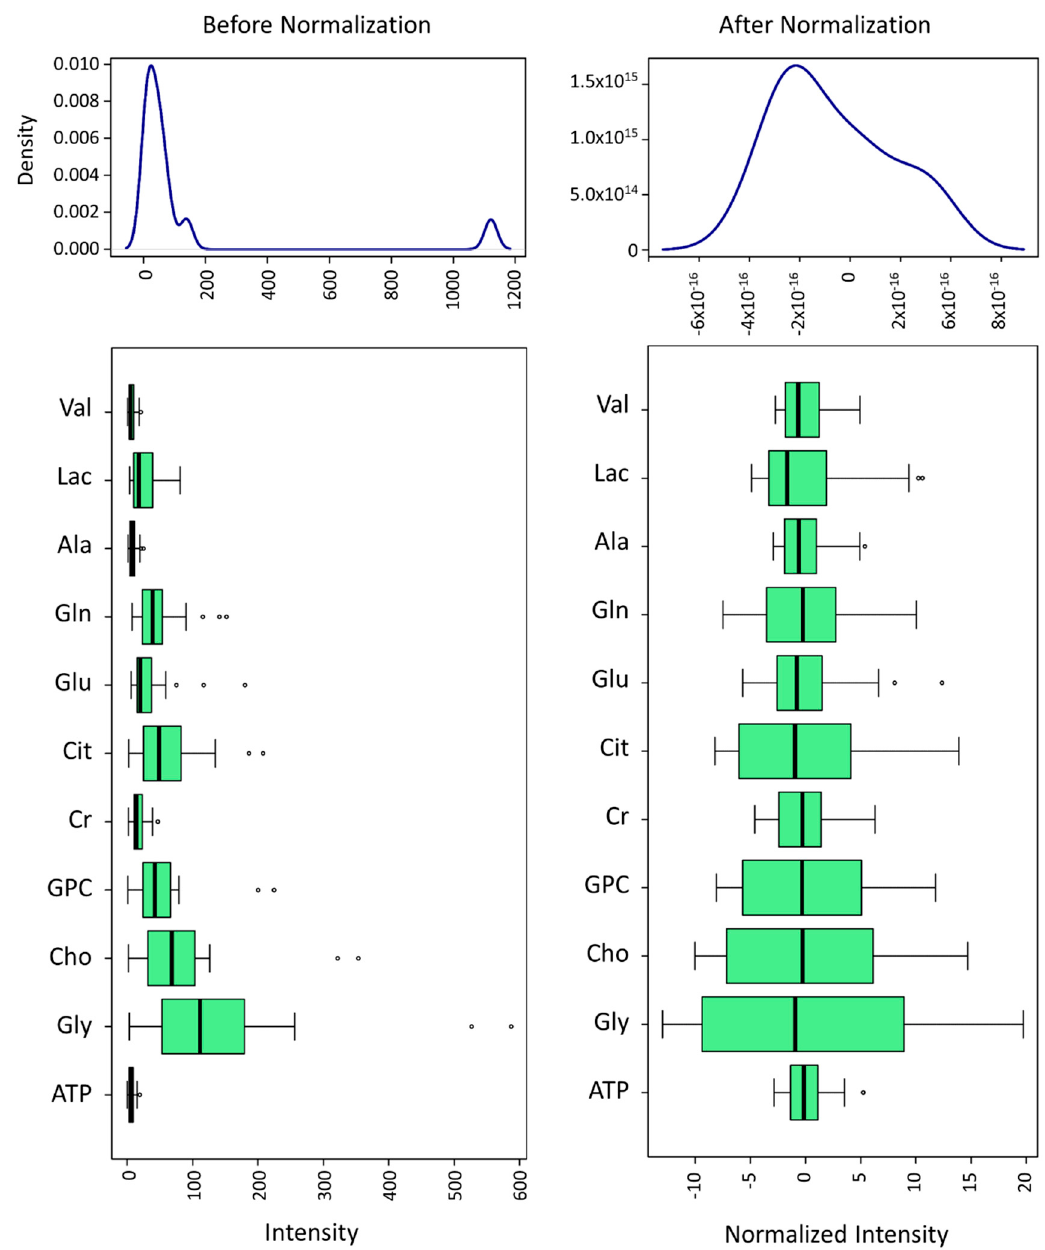
Figure 2. Selected metabolites’ spectral bin data normalization to DSS of pig seminal plasma, generated using MetaboAnalyst. Adenosine Triphosphate (ATP), Alanine (Ala), Choline (Cho), Citrate (Cit), Creatinine (Cr), Glutamic acid (Glu), Glutamine (Gln), Glycine (Gly), Glycerophosphocholine (GPC), Lactate (Lac) and Valine (Val). Normalization was performed with pareto-scaling and is shown on the left side. Empty dots in box-plots represent the outlier values both before and after normalization. Values were classified as outliers when their value was lower than 1.5 times the 25th percentile or higher than 1.5 times the 75th percentile.